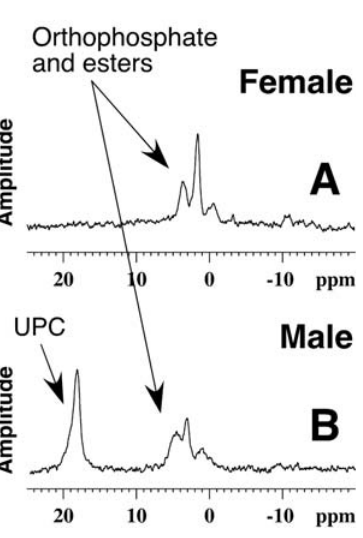
Figure 1. P-31 NMR spectra of male and female gills. Two P-31 NMR spectra of primary lamellae of female gill (A) and male gill (B)